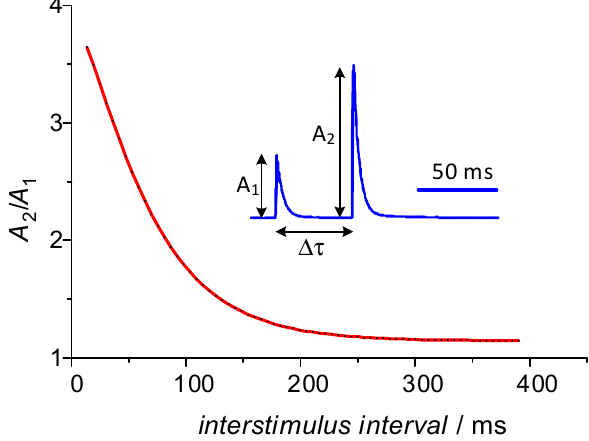
Figure 2. An example of the paired-pulse facilitation observed in nervous system. Adapted from [31]